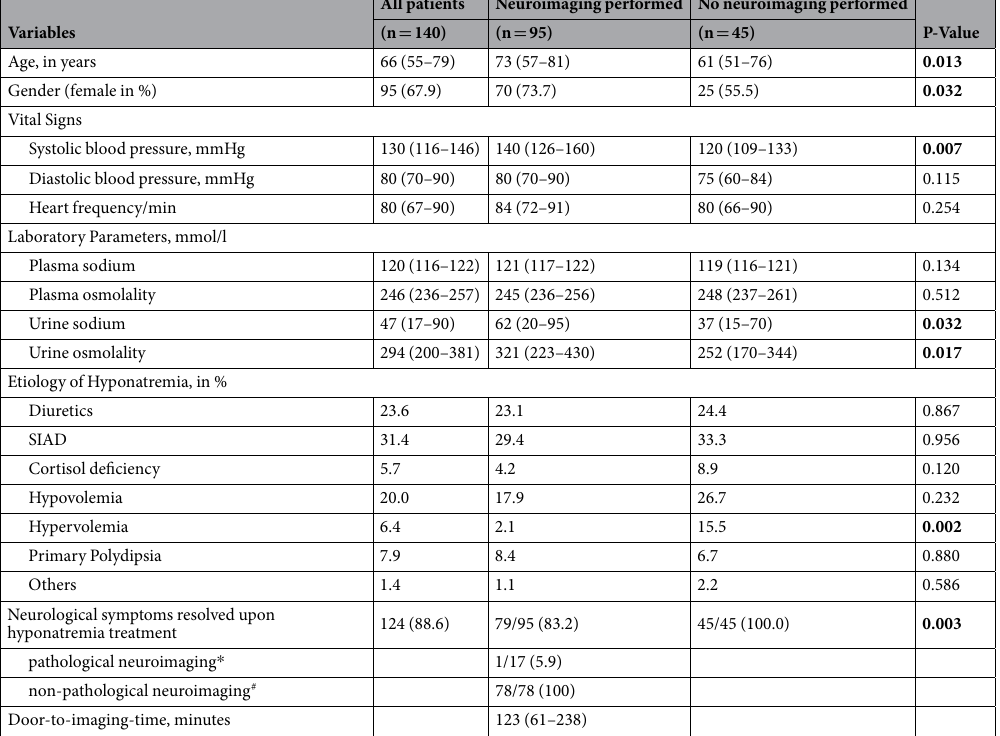
Table 1. Characteristics of patients with severe hyponatremia and neurological symptoms. Median and interquartile range reported for continuous variables and frequency; percentage reported for categorical variables. Differences between patients with/without neuroimaging were calculated using the Mann-Whitney U test for continuous variables and the Chi-square test for categorical variables. Two-sided p values < 0.05 were considered statistically significant. SIAD, syndrome of inappropriate antidiuresis (SIAD). * Pathological neuroimaging: neuroimaging showed findings related to acute symptomatology, e.g., ischemic stroke. # Non- pathological neuroimaging: neuroimaging was unremarkable (no incidental/pathological finding) or showed incidental findings not related to acute symptomatology, e.g., general cerebral atrophy, old ischemic